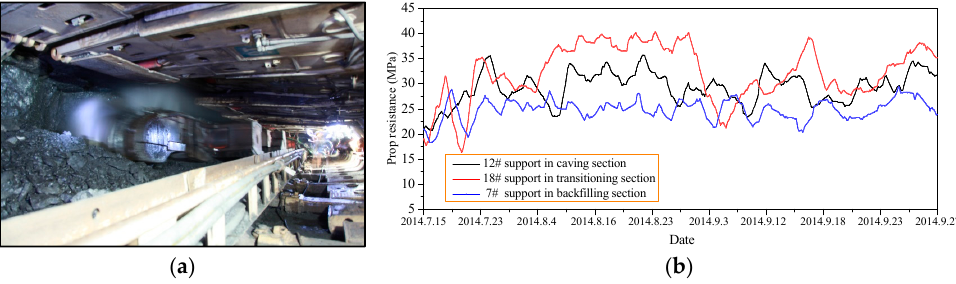
Figure 14. Prop resistance measurement by the supports in the mixed longwall face: ( a ) scene photos; ( b ) the curve of the prop resistance